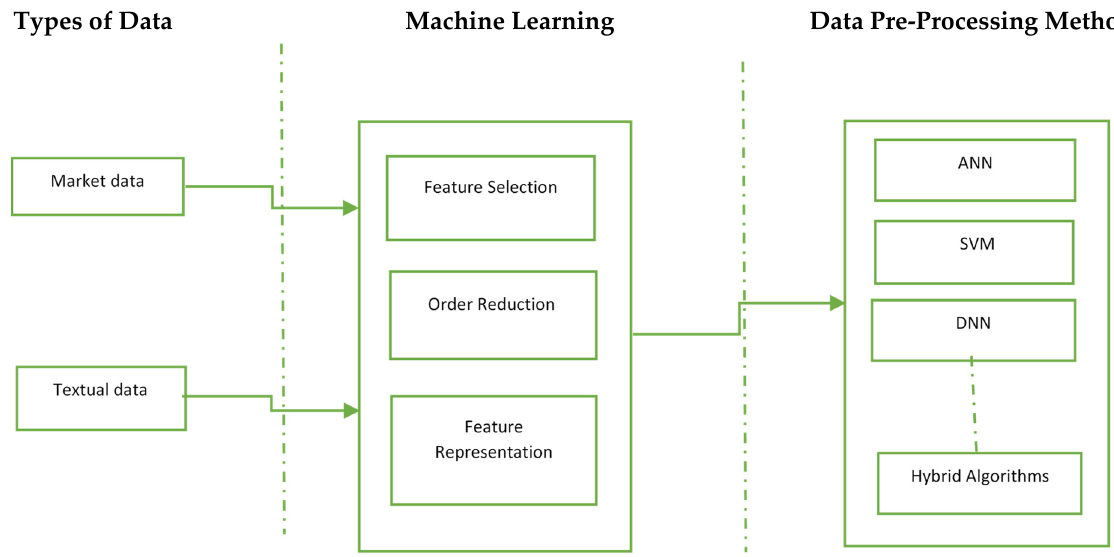
Figure 3. Generic Scheme for SMP (Stock Market Prediction).